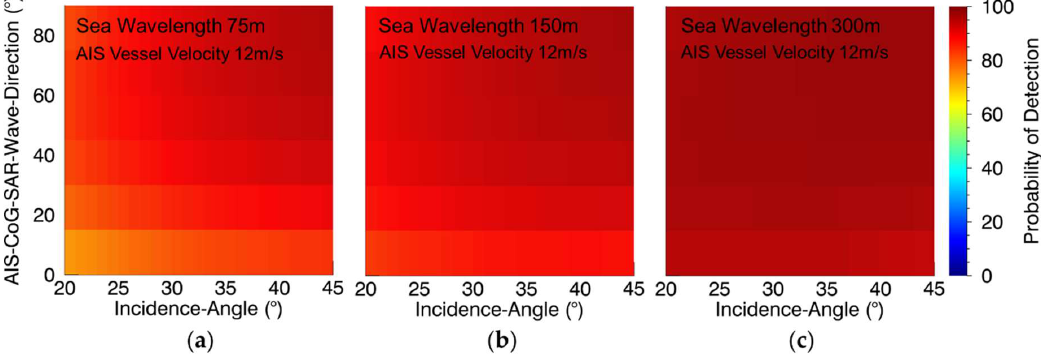
Figure 7. 2D detectability charts based on Incidence-Angle, AIS-CoG-SAR-Wave-direction and from left to right SAR-Significant-Wave-Length with: ( a ) 75 m, ( b ) 150 m, and ( c ) 300 m, deviating from the default setting for this chart AIS-Vessel-Velocity was set to 12 m/s.